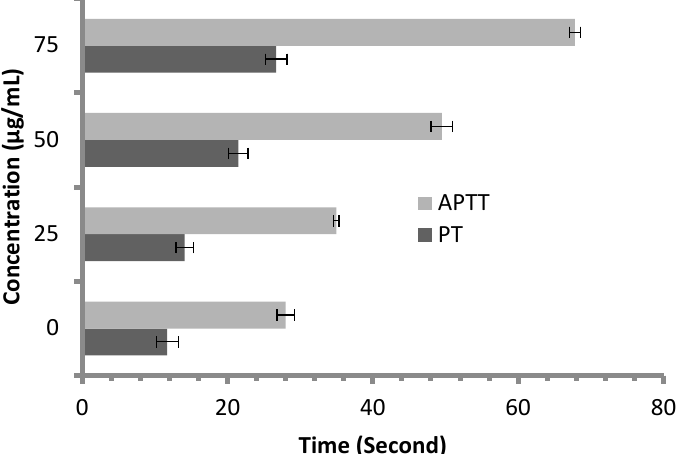
Figure 8. Anticoagulant activity of M. pulegium at different concentrations, represented by PT and APTT.